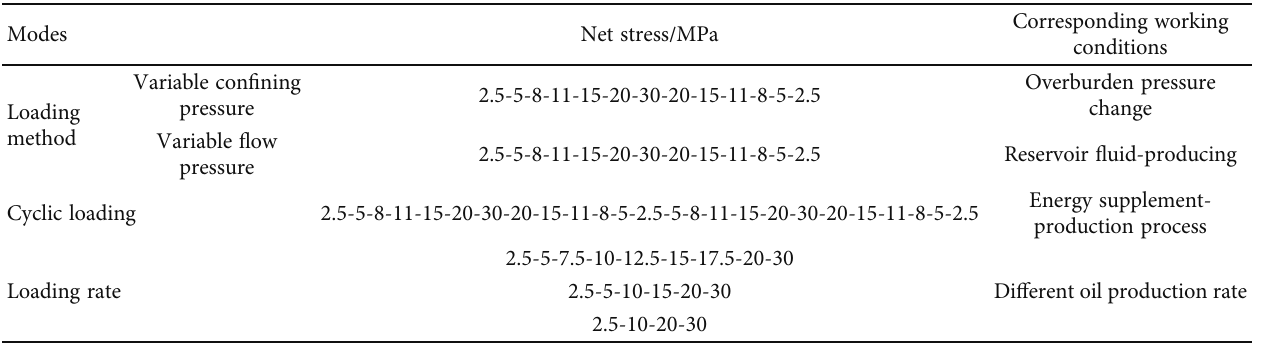
Table 4: Di ff erent net stress change modes and their correspondence with actual working